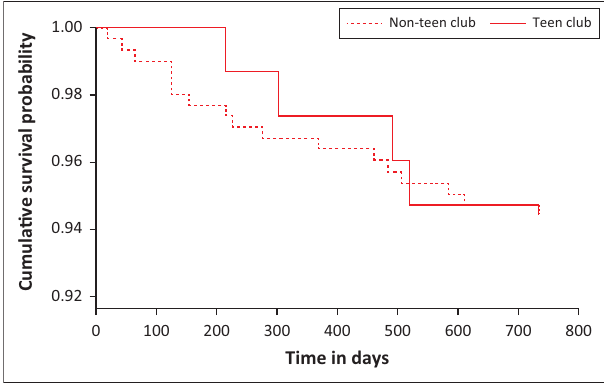
FIGURE 2: Kaplan–Meier survival analysis for retention in care among Teen Club members and adolescents in standard care over time.